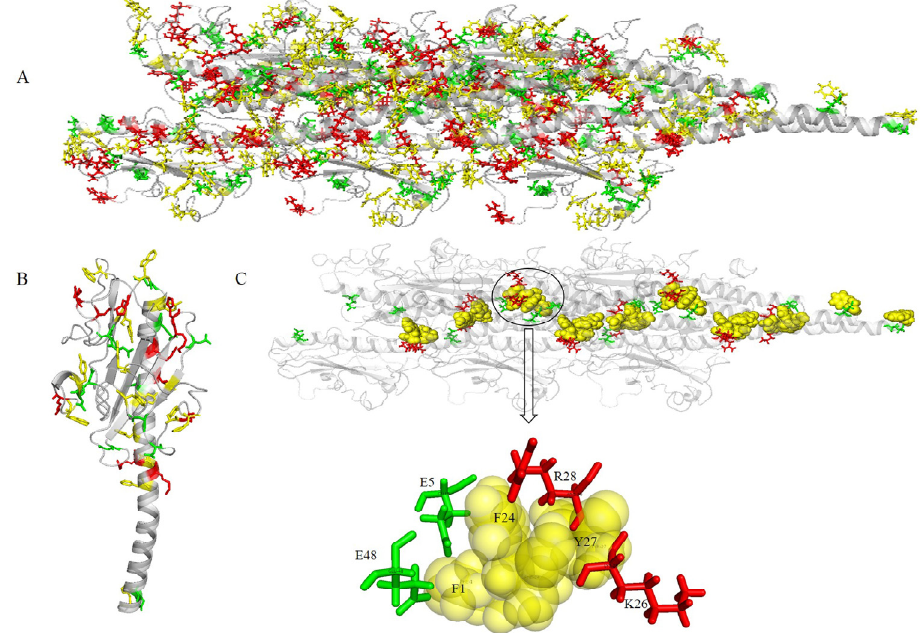
Figure 7. Spatial distribution of aromatics and charged amino acids. Gray schematic represents the structure of a pilus. ( A ) Yellow, red, and green sticks indicate the spatial distribution of aromatic, positive, and negative amino acids, respectively. ( B ) A monomer extracted from structure ( A ). ( C ) Four charged amino acids (E5, K26, R28, and E48) in close proximity to the aromatic amino acids of the charge transport path.